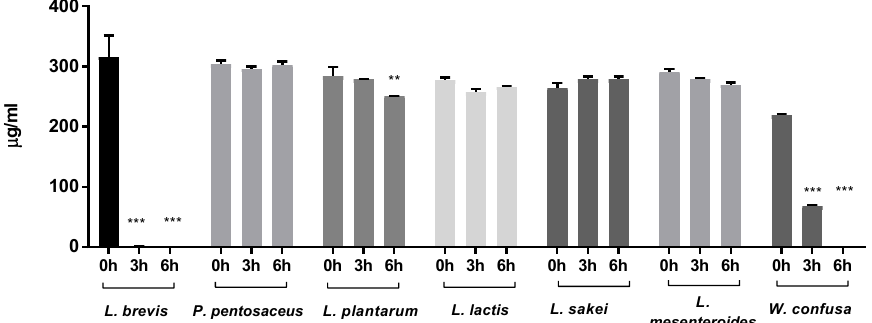
Figure 1. Arginine consumption by lactic acid bacteria isolated from kimchi. Bacteria were cultivated in De Man, Rogosa, and Sharpe (MRS) medium, and the arginine contents in the media over time were quantified